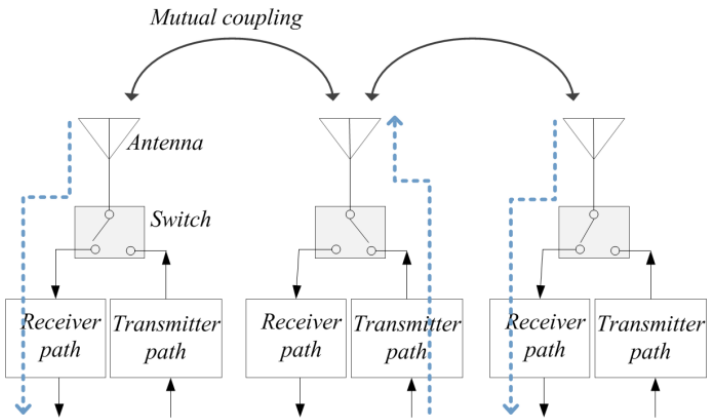
Figure 1. The antenna structure of a typical phased array. The receiver and transmitter share an identical antenna. The switch controls the transform between receiving mode and transmitting mode. A mutual coupling exists between adjacent antennas.